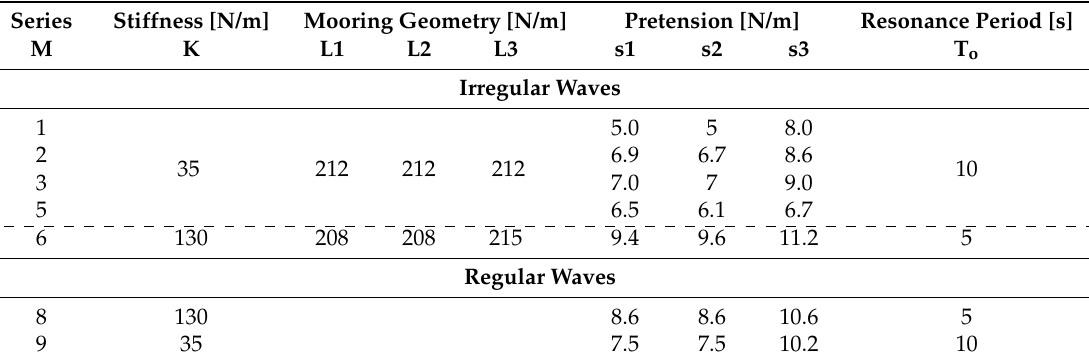
Table 6. Experimental setups and test series.